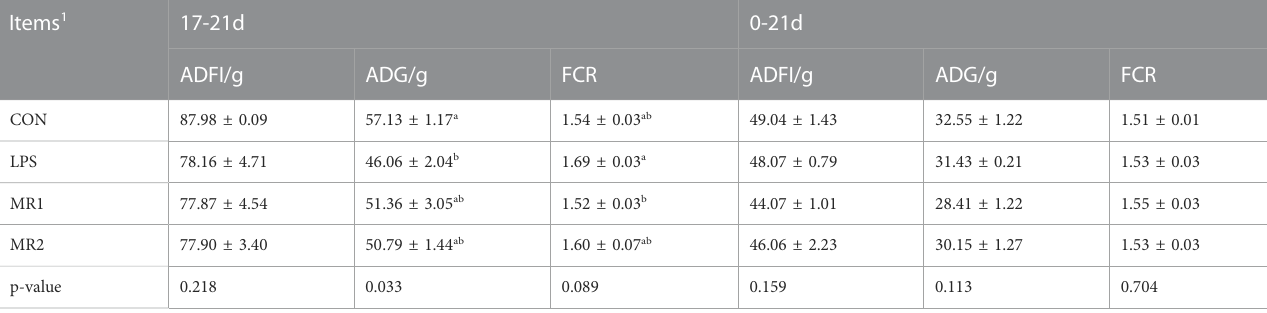
TABLE 3 Effects of dietary methionine restriction on growth performance of LPS-stimulated broilers (n = 6). Items 1